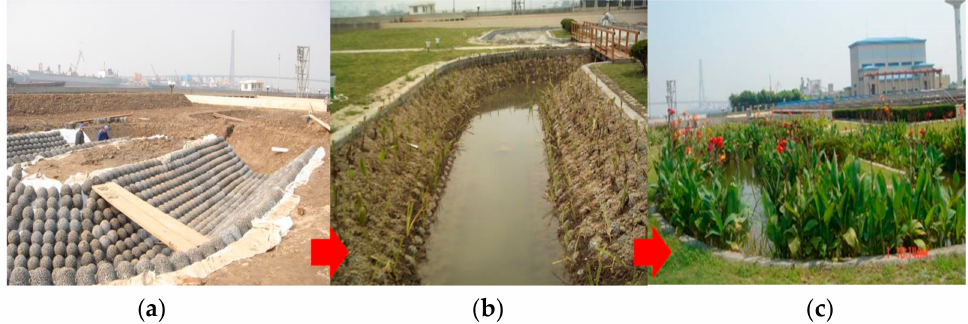
Figure 2. The prefabricated sphere of porous concrete and aquatic plant involved in bank slope ecological revetments for Ditch A. ( a ) porous concrete pavement ( b ) backfilling soil ( c ) planting